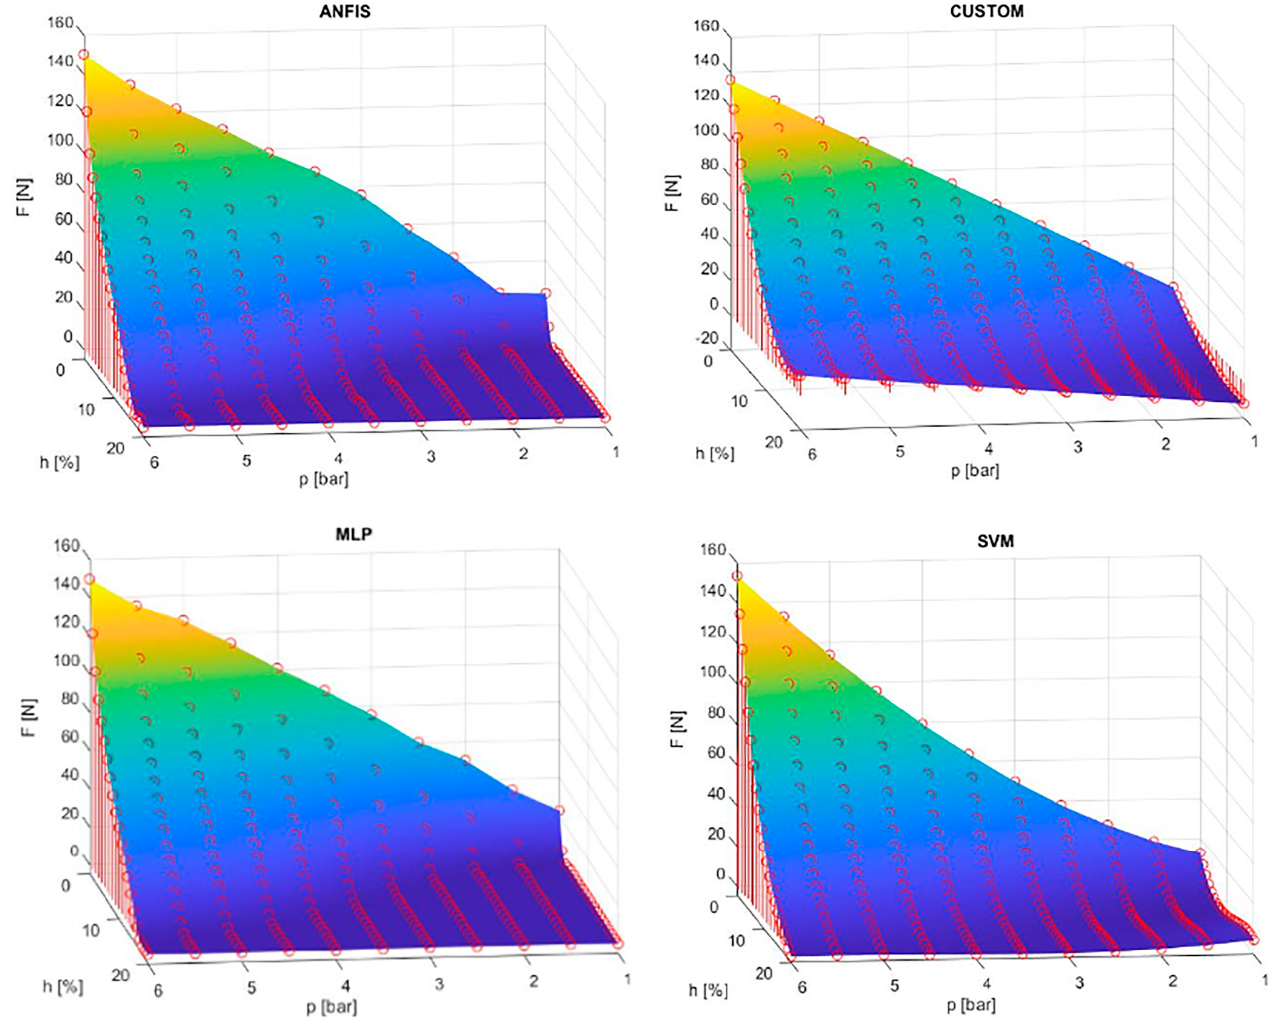
Figure 13. Relations of force, contraction, and pressure approximated by the ANFIS, custom, MLP, and SVM models for the DMSP − 5 muscle.